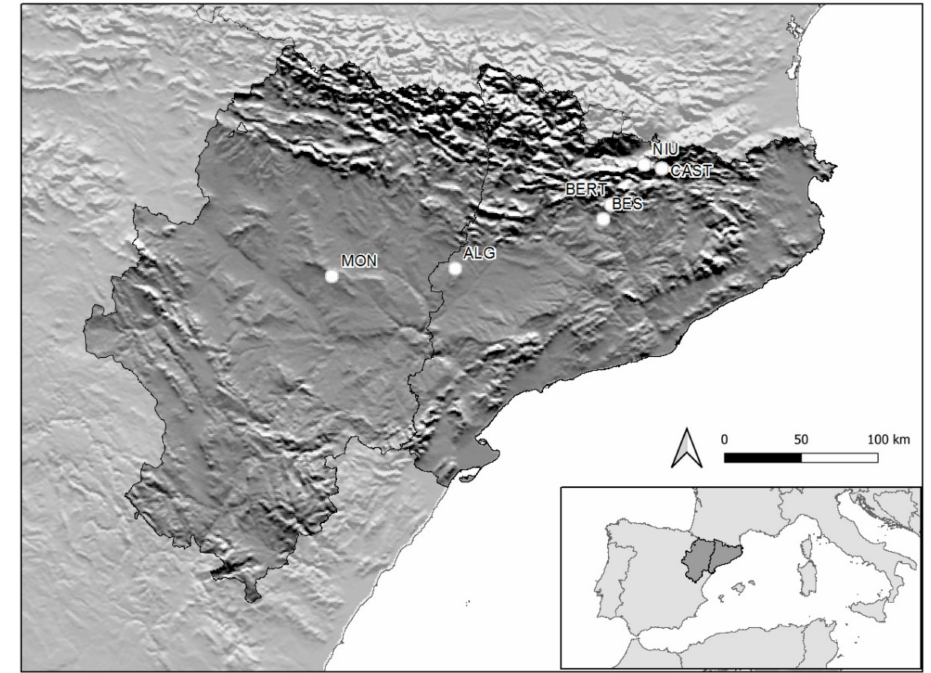
Figure 1. Location of the six study sites: MON (Monegrillo), ALG (Alguaire), BES (Besora), BERT (La Bertolina), CAST (Castellar de n’Hug), and NIU (Niu de l’ À liga). The borders in the map represent the limit between Catalonia and Arag ó n. The spatial scale of the map is 1:2,000,000 and the resolution of the raster surface is 930 m. Table 1. General climatic and management characterization of the six study sites: Alguaire (ALG), Monegrillo (MON), Besora (BES), La Bertolina (BERT); Niu de l’ À liga (NIU). Variables ALG MON BES BERT CAST NIU Latitude 41 ◦ 43 (cid:48) 46,60”